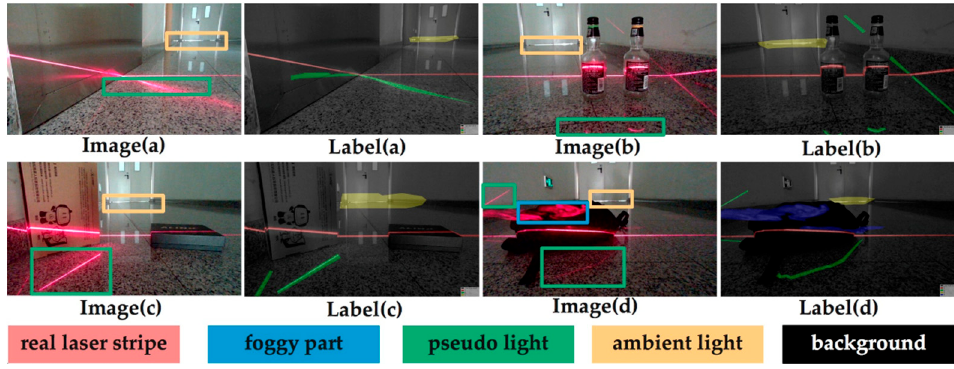
Figure 4. Image Figure 4. Image labeling.